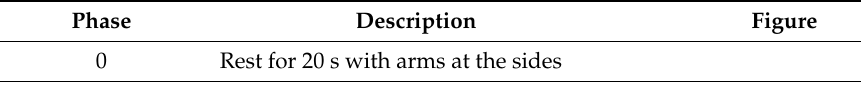
Table 2. Overall system raw signal reliability protocol.